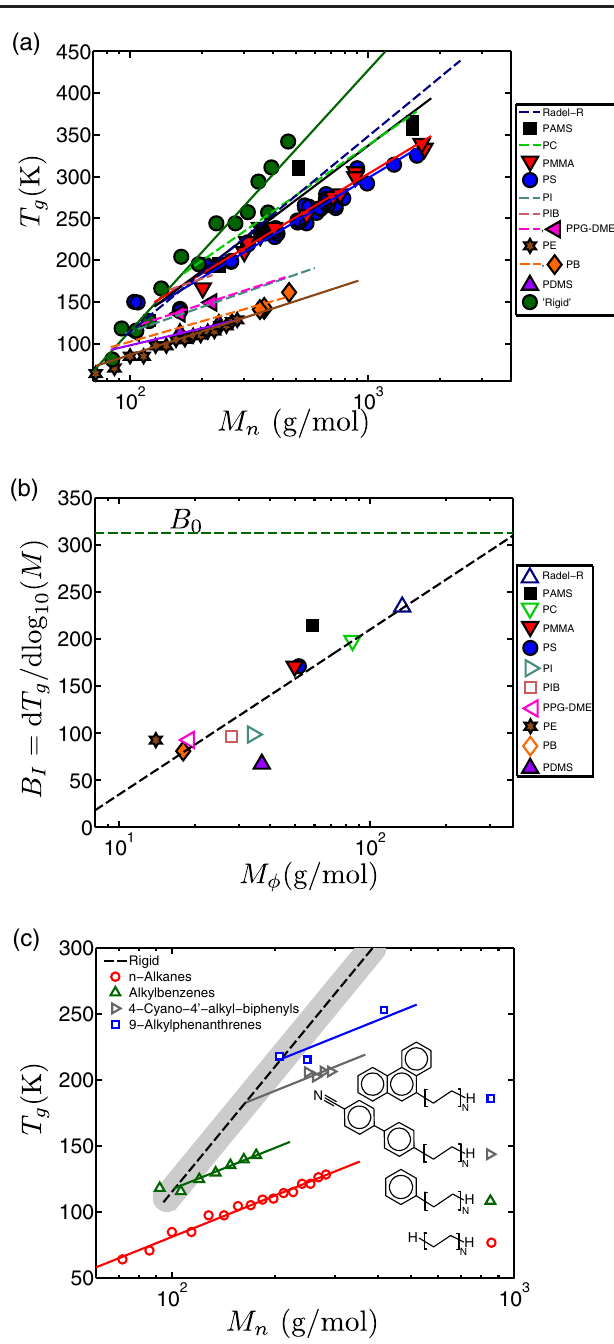
FIG. 4. (a) Glass-transition temperature T vs molecular weight g M within regime I for polymers and rigid nonpolymeric mole- A B cules. The solid lines are fits of the form T log 10 M . g ¼ I þ I For polymers with no (PC, PI, PIB, Radel-R) or sparse (PB, PPG- DME) data in regime I, the master curve in Fig. 2(e) is used to predict the regime I behavior, which is shown as dashed lines. dT =d log 10 M vs log 10 ð M ϕ Þ ; (b) Chain mass sensitivity B I ¼ g B 0 ¼ dT =d log 10 M for the nonpolymeric rigid molecules, g shown as a horizontal dashed line. (c) T for four different chain g series of n-alkanes (PE) with end groups of different size. The M Þ behavior of the rigid dashed shaded line marks the T g ð nonpolymeric molecules, as shown by green circles in panel